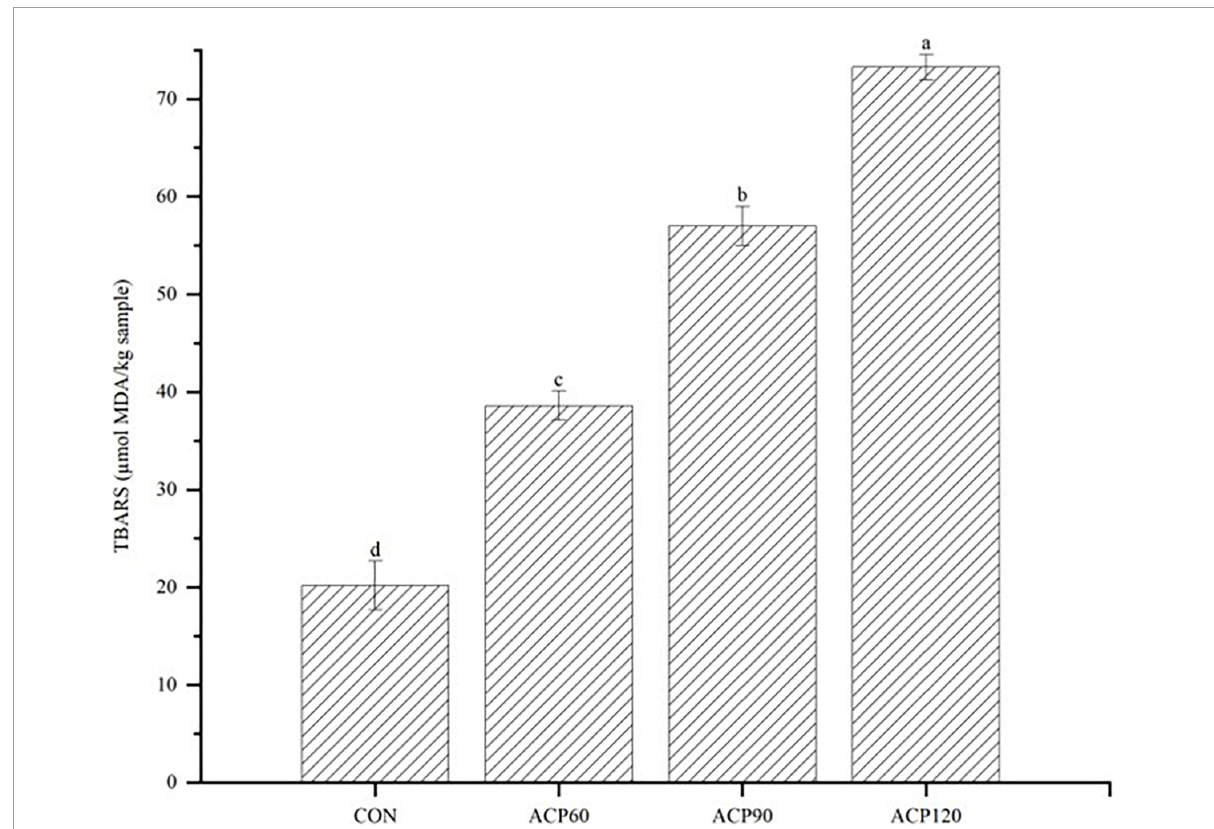
FIGURE7 The analysis of TBARS content of surimi gels subjected to different treatment times. The different lowercase letters represent significant differences ( p < 0.05.) (CON, surimi gels without ACP treatment; ACP60, surimi gels treated with ACP for 60 s; ACP90, surimi gels treated with ACP for 90 s; ACP120, surimi gels treated with ACP for 120